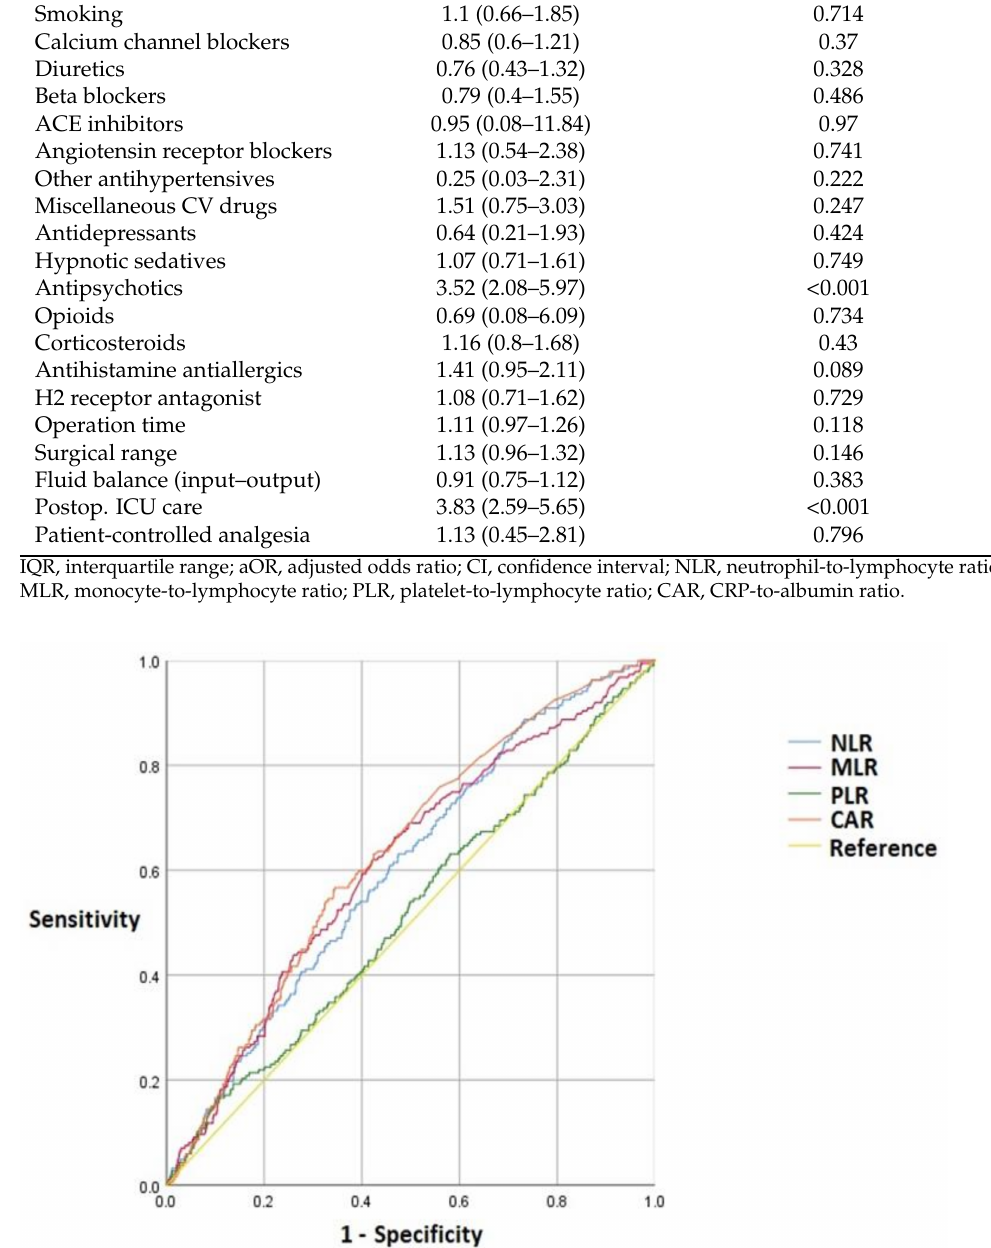
Figure 2. ROC curve showing the discriminative ability of the inflammatory markers (NLR, MLR, PLR, and CAR) in the POD and non-POD groups. ROC, receiver operating characteristic; NLR, neutrophil-to-lymphocyte ratio; MLR, monocyte-to-lymphocyte ratio; PLR, platelet-to-lymphocyte ratio; CAR, CRP-to-albumin